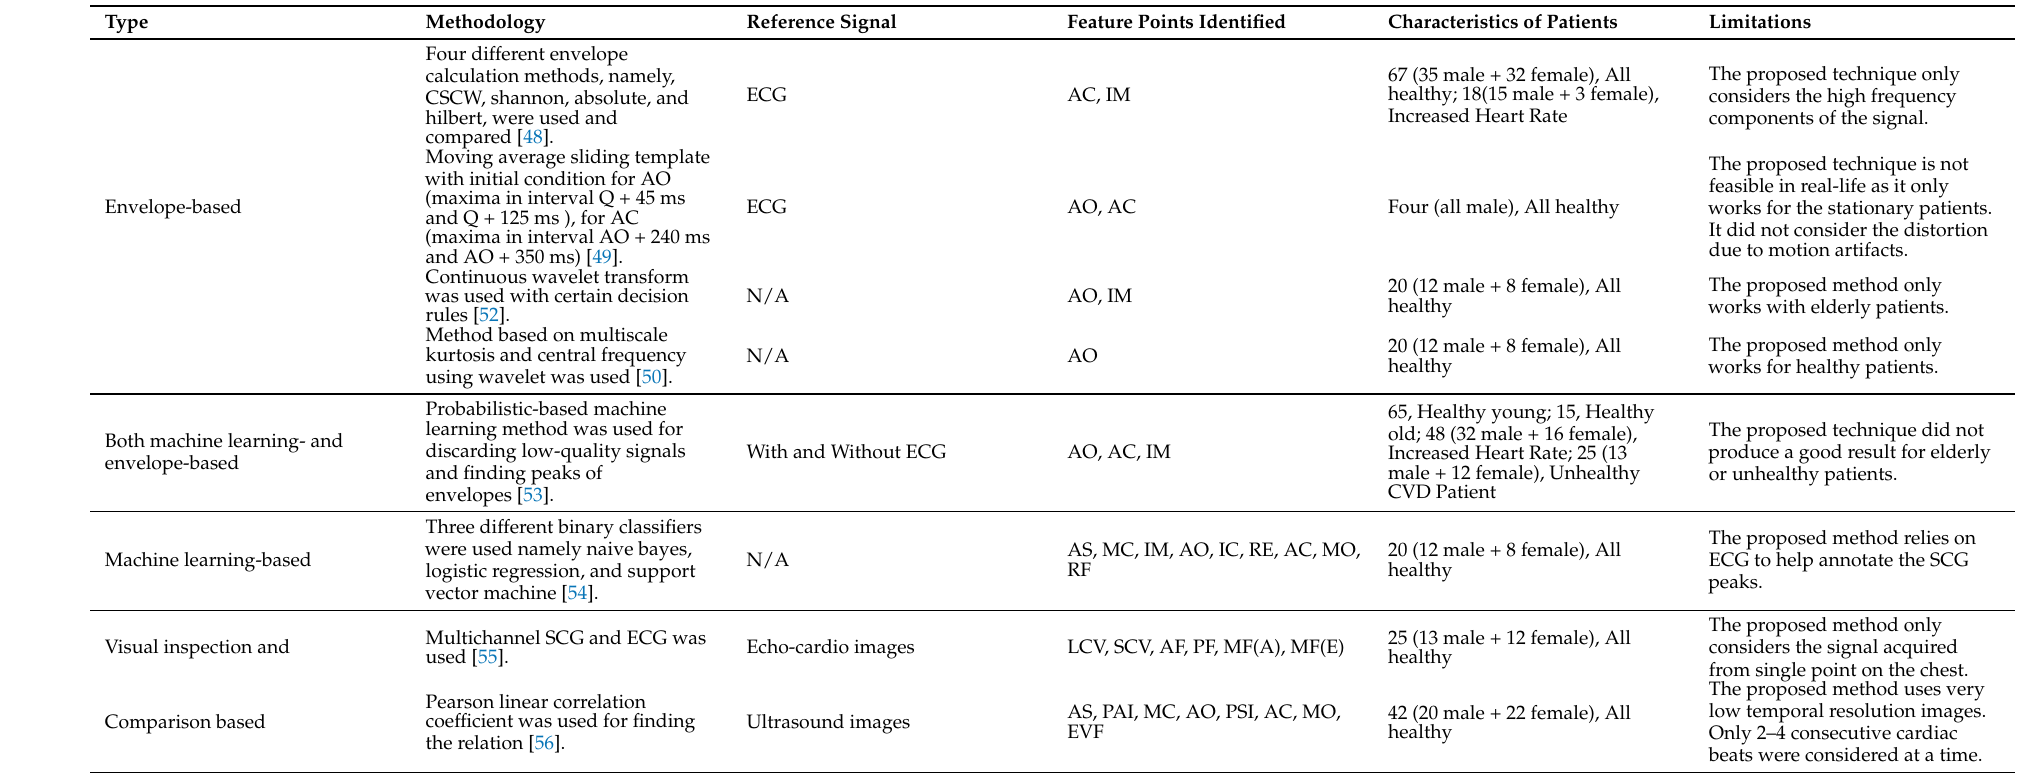
Table 3. Comparison of SCG Annotation